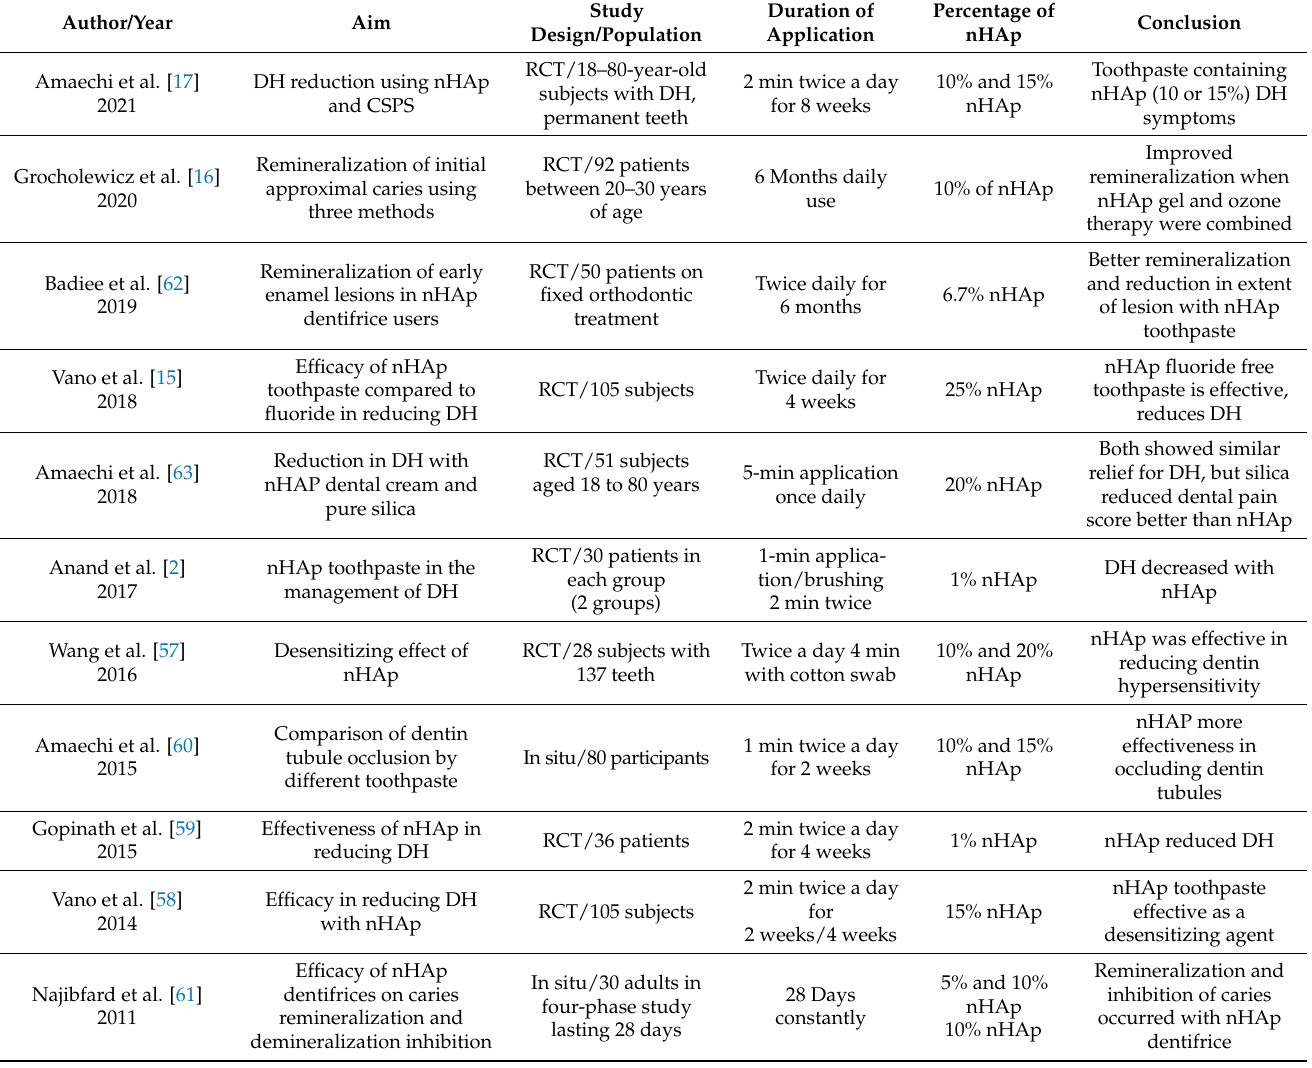
Table 4. Summary of publications that reported effects of nano-hydroxyapatite dentifrices in human clinical